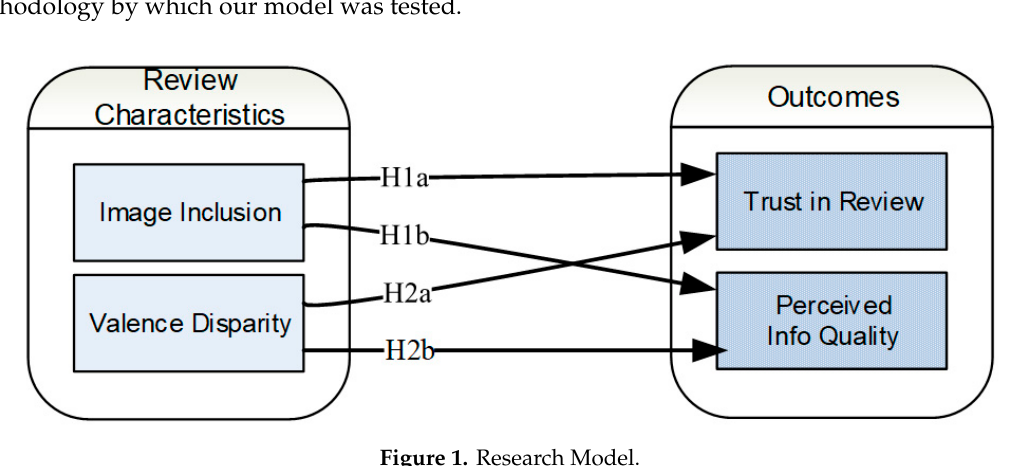
Figure 1. Research Figure 1. Research Model.